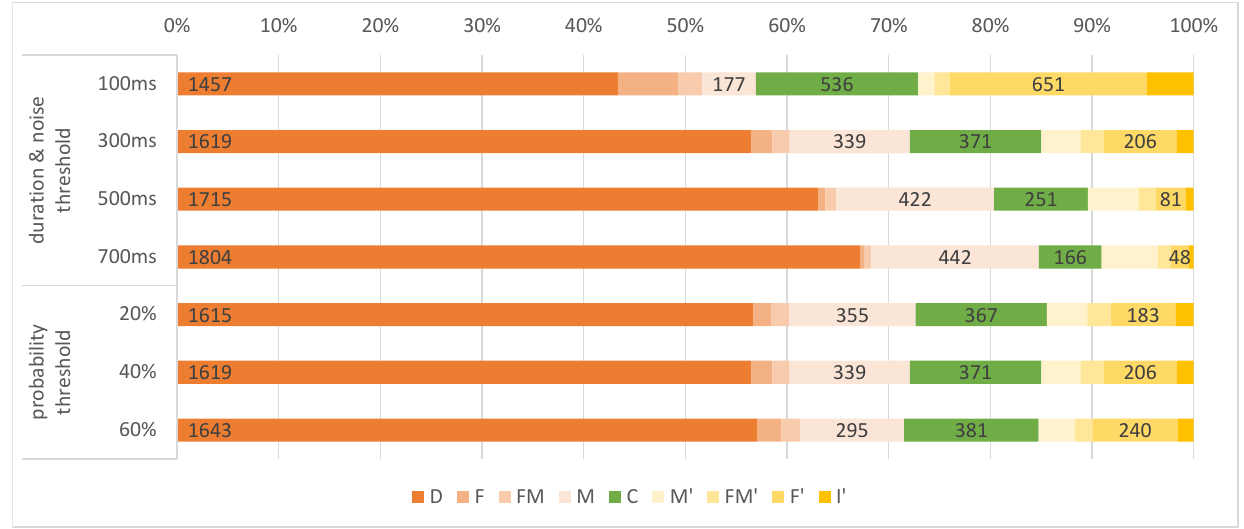
Figure 6. Simplified EAD diagrams for IC methods with varying parameters aggregated over AOIs with non-zero recall. We vary the probability threshold T p or the duration and noise threshold T dur = T noise . We use default values for other parameters. The results for 300 ms and 40% refer to the default setting IC-152-300-40 as shown in Figure